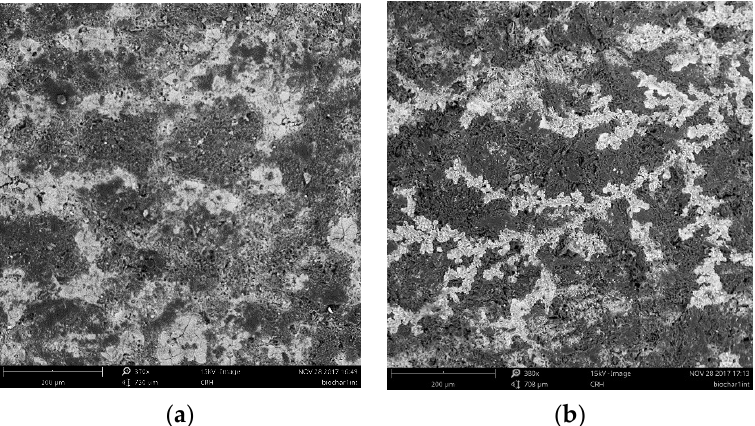
Figure 4. Inner ( a ) and outer ( b ) cathode surfaces at 370× and 380× magnification. The arrows in ( a ) mark residues that can be ascribed to biofilm growth while in ( b ) arrows indicate salts (mainly NaCl) depositions.